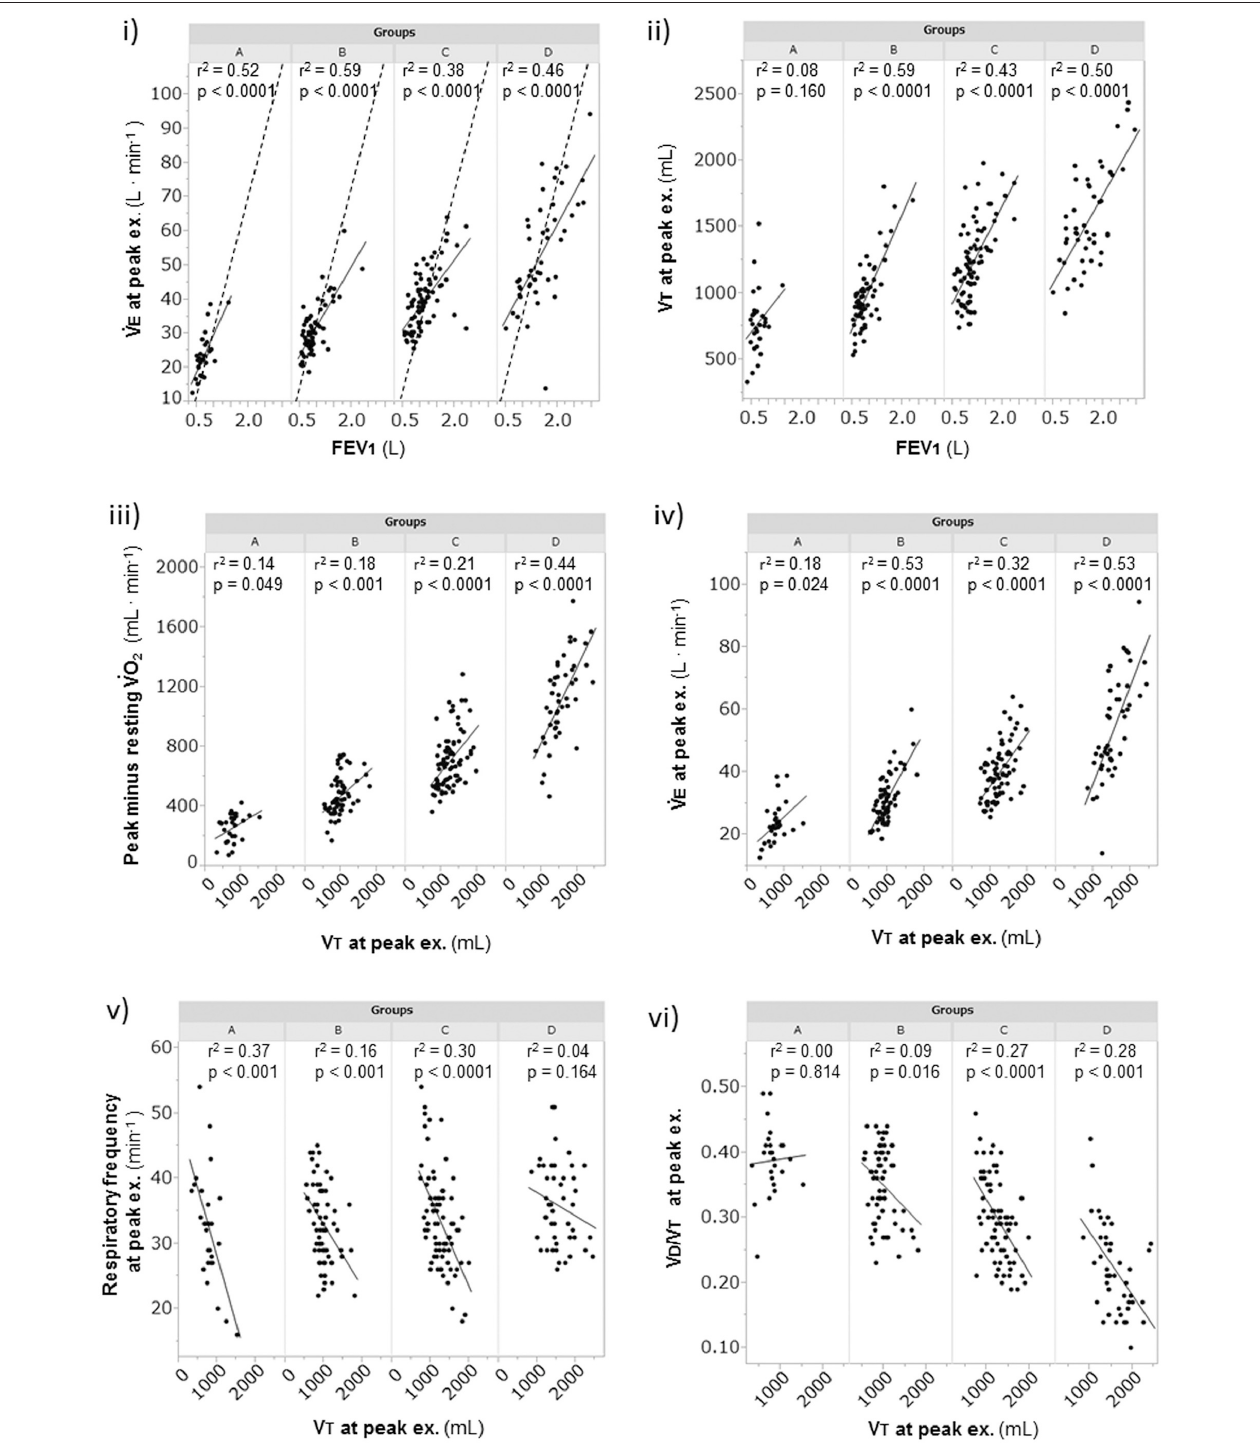
FIGURE 3 | The relationships of the FEV 1 and the V T at peak exercise during cardiopulmonary exercise testing. (i) relationship of ˙ V E to FEV 1 , (ii) relationship of V T to FEV 1 , (iii) relationship of obtained ˙ V O 2 to V T , (iv) relationship of ˙ V E to V T , (v) relationship of respiratory frequency to V T , and (vi) relationship of V D /V T to V T . Group A ( < 11 mL · min − 1 · kg − 1 ); group B (11 to < 15 mL · min − 1 · kg − 1 ); group C (15 to < 21 mL · min − 1 · kg − 1 ); and group D ( ≥ 21 mL · min − 1 · kg − 1 ). The dotted lines represent indirect MVV, which was calculated as FEV 1 × 35. EX., exercise; FEV 1 , forced expiratory volume in 1s; MVV, maximum voluntary ventilation; V D /V T , physiologic dead space/tidal volume ratio; ˙ V E , minute ventilation; ˙ V O2 , oxygen uptake; V T , tidal volume.